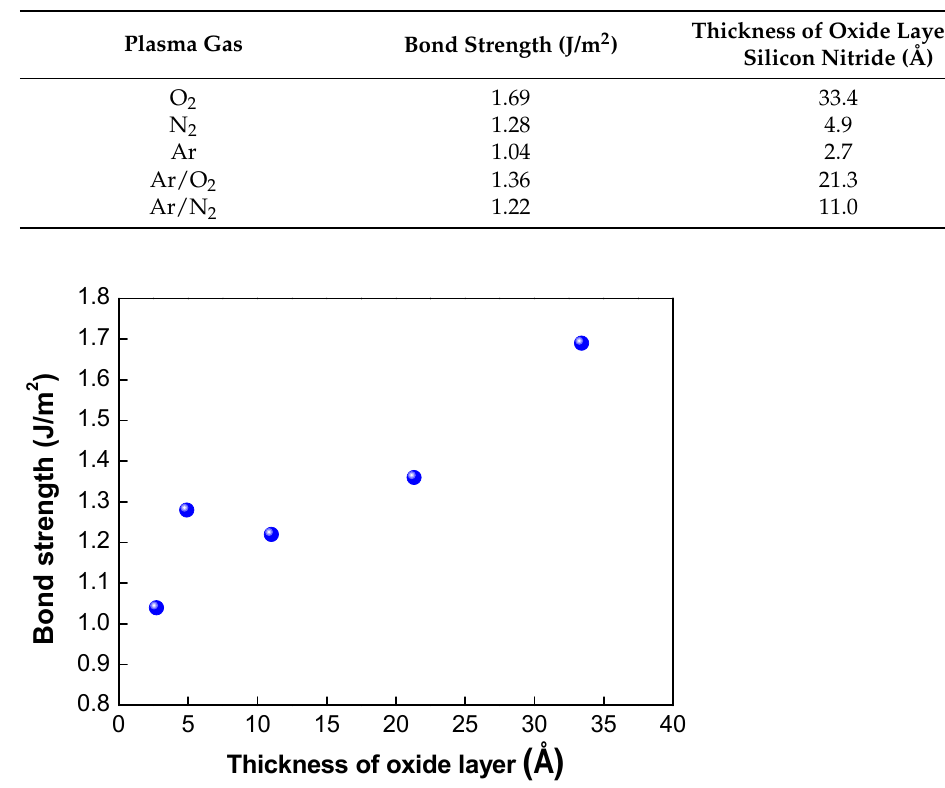
Table 2. Bond strength and thickness of the oxide layer under various plasma power conditions.